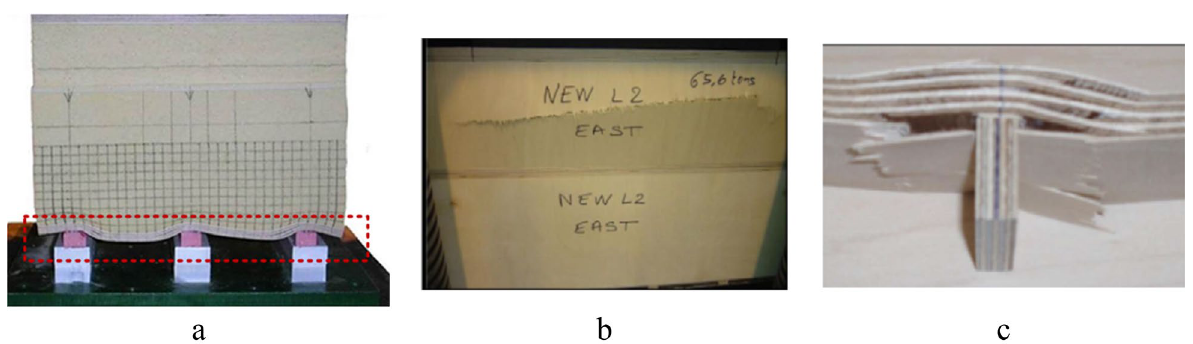
Fig. 2 Photographs of the failure characteristics of GTT membrane‑type LNG cargo containment system caused by compressive load: a buckling and crushing of Mark‑III [5], b buckling of primary bulkhead of NO96 [20], and c fracture of primary cover plate of NO96